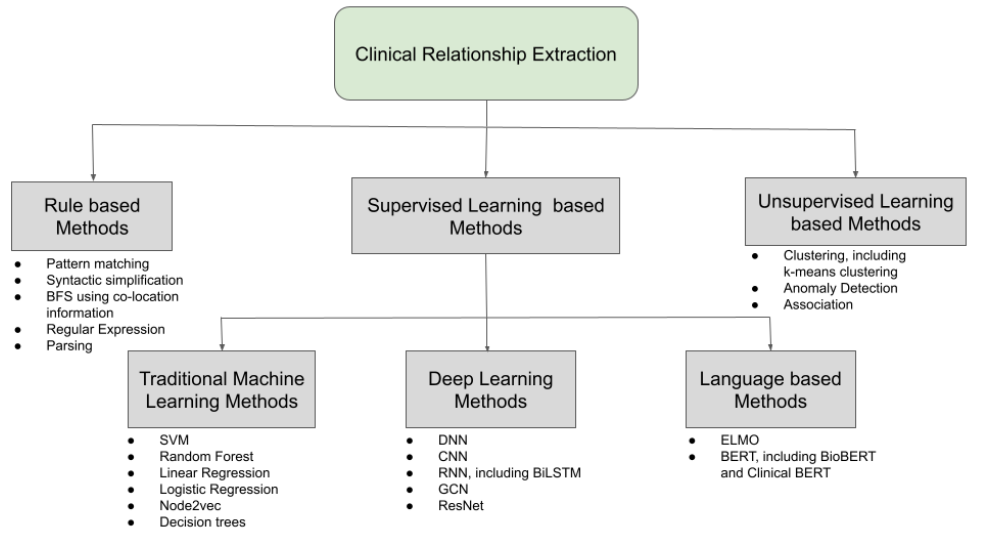
Figure 6. Different learning methods used for clinical